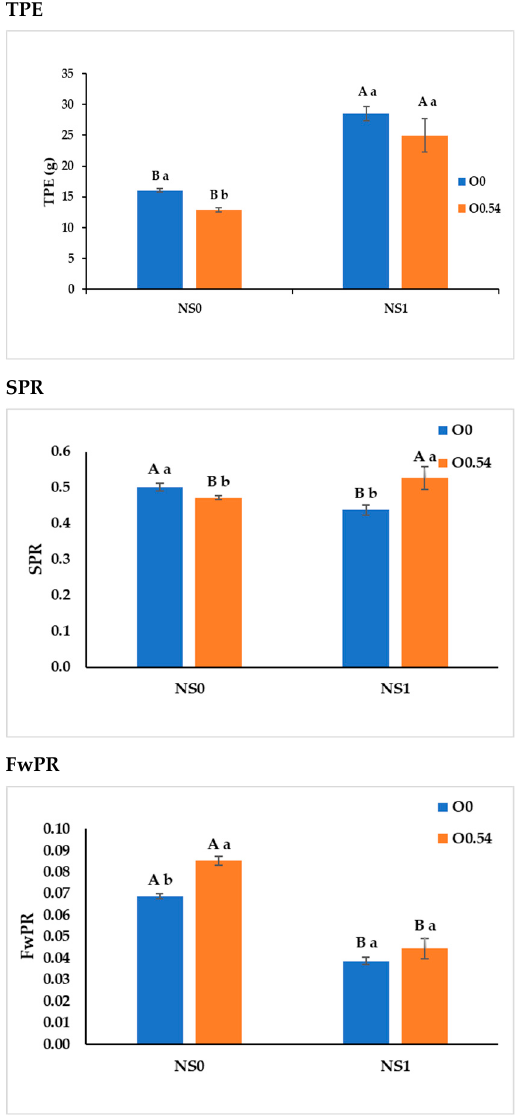
Figure 5. Interactions between fertigation treatments and O 3 supply on total phosphorus extracted (TPE) from plants, RPR, SPR, LPR, and FwPR. The comparison between the ozone supplies is assessed with lowercase letters. Capital letters are used to analyze the comparability of fertigation treatments. Different letters denote significant treatment changes (LSD test, p < 0.05).